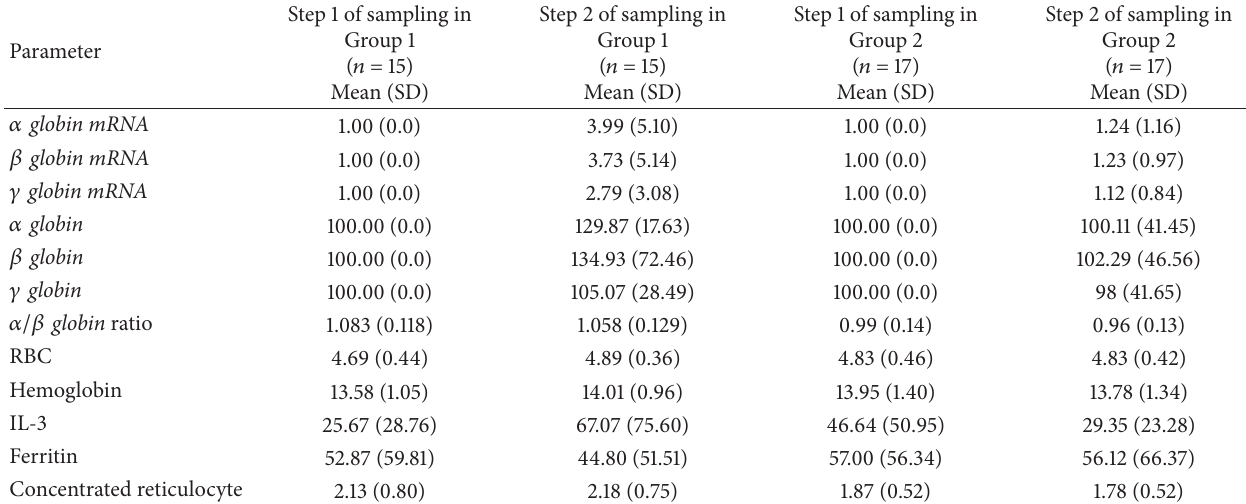
Table 4: Summary of the